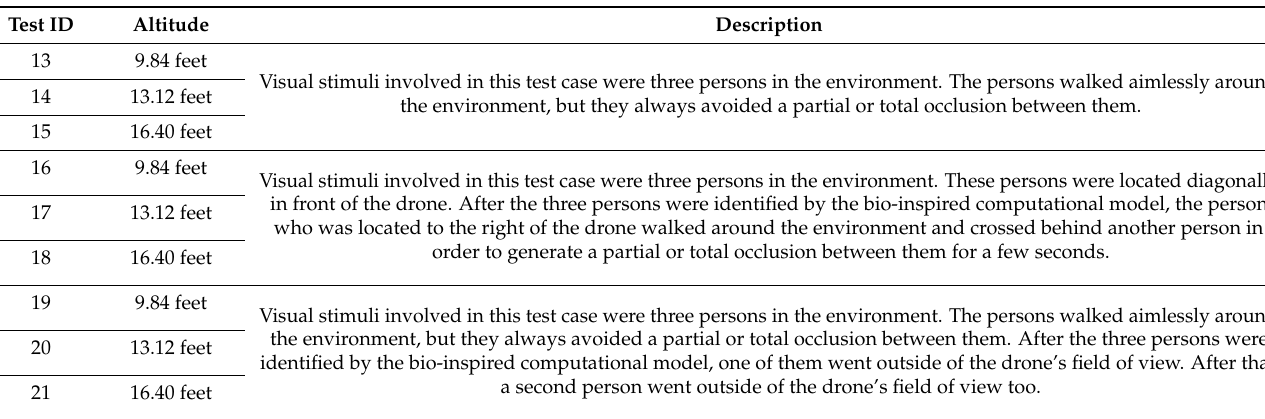
Table 3. Test cases with